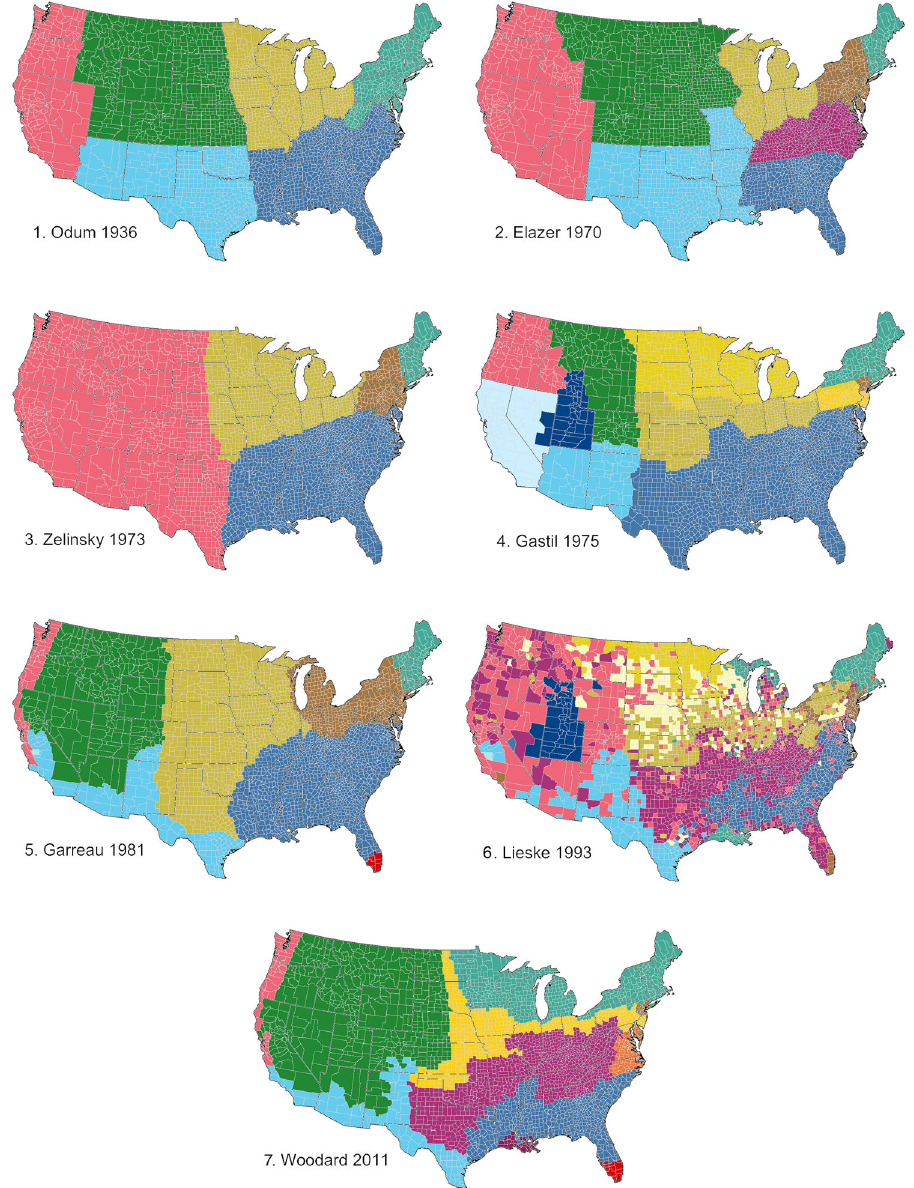
Fig. 1 American cultural regions identi fi ed in previous studies. These maps are generated from a compilation of results given in eight previous studies (Elazar, 1970; Garreau, 1996; Gastil, 1975; Lieske, 1993; Odum, 1936; Woodard, 2012; Zelinsky, 1973).